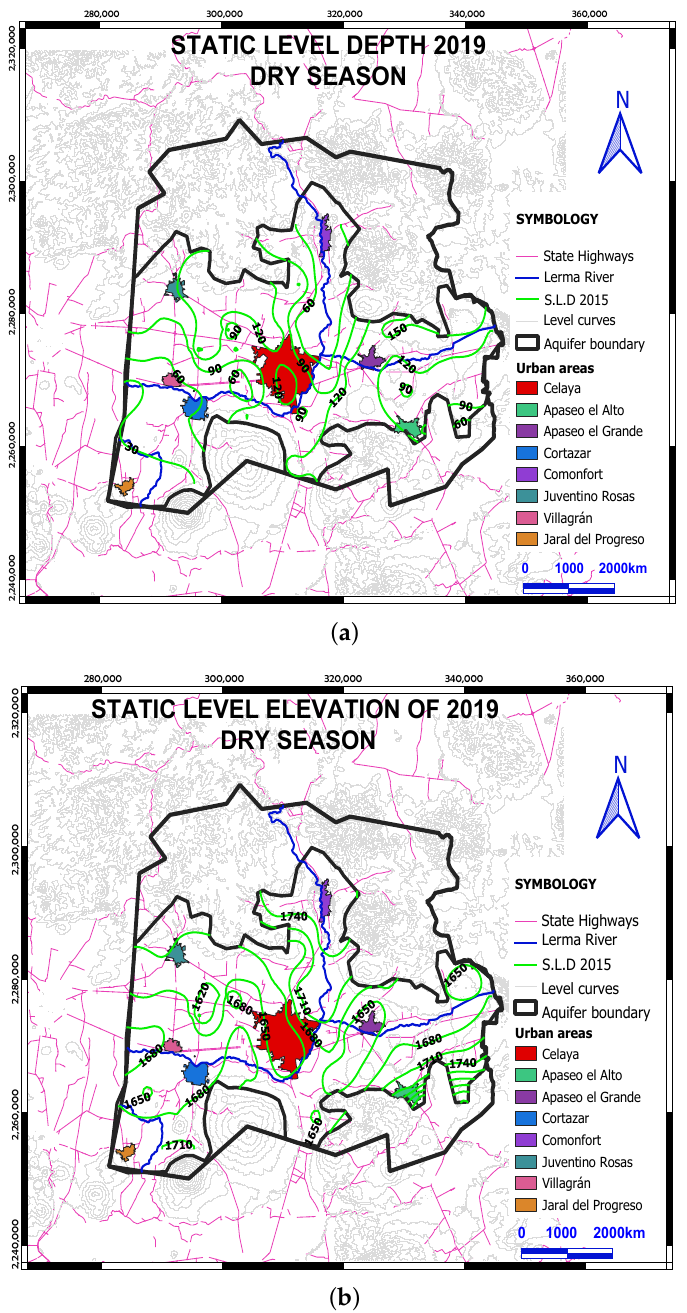
Figura 1.14: Temporada de Secas: Elevaci´on del nivel est´atico en el a˜no 2019. Figure 5. Dry season of 2019. ( a ) Distribution of static level depth lines. ( b ) Distribution of static level elevation Temporada de Lluvias